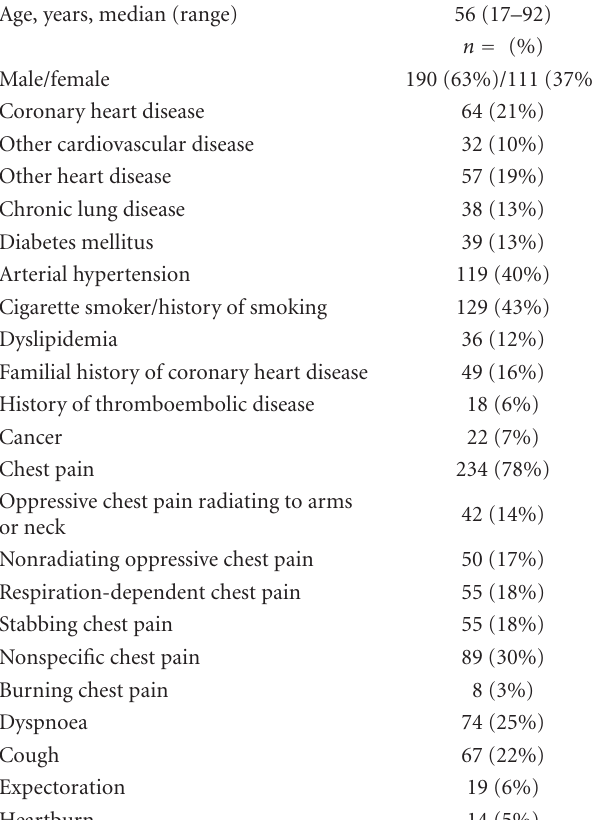
Table 1: Characteristics of 301 Patients. Table 2: Final diagnosis at the ED of 301 Patients †